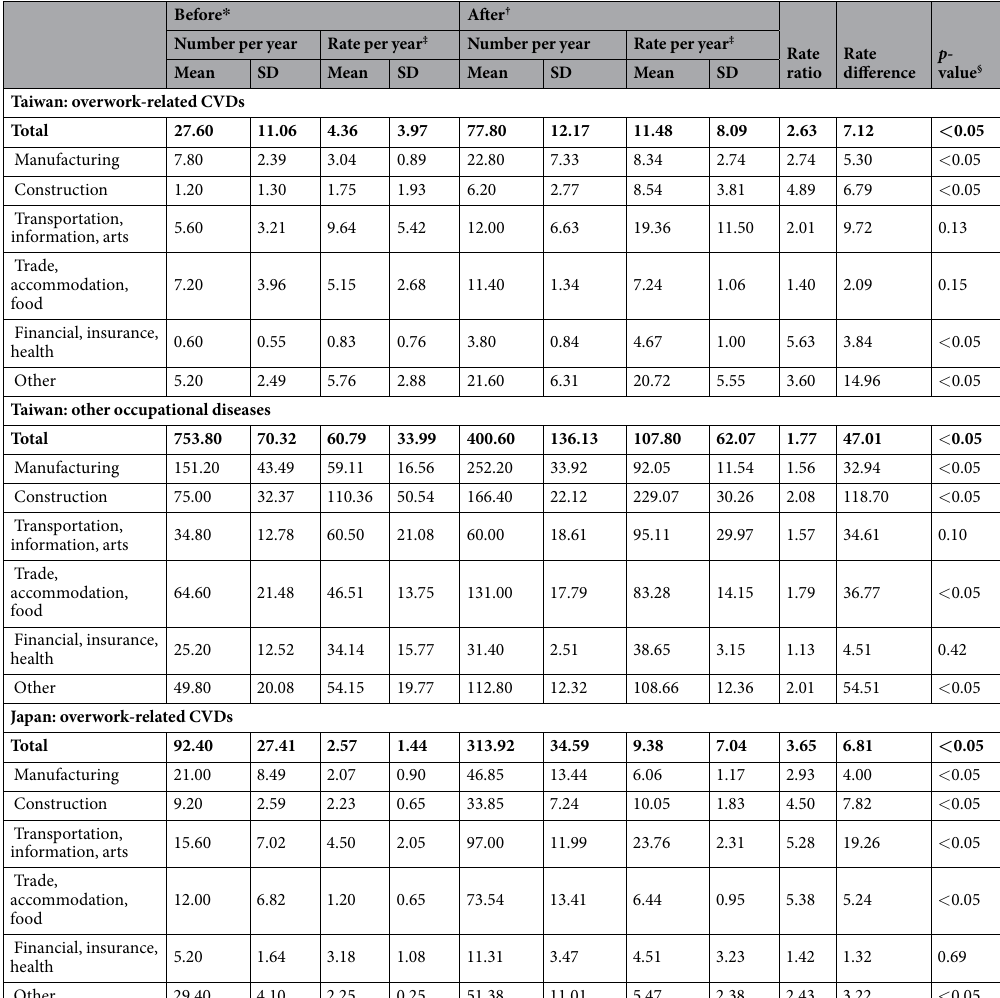
Table 4. Numbers, rates, rate ratios, and rate differences for overwork-related cardiovascular and cerebrovascular diseases (CVDs) and other occupational diseases in Taiwan and Japan before and after implementation of new criteria for overwork-related CVDs. SD = standard deviation. * Defined as 5 years before new criteria: 2006–2010 for Taiwan and 1997–2001 for Japan. † Defined as 5 years after new criteria: 2011–2015 for Taiwan and 2002–2006 for Japan. ‡ Per million employees. § Wilcoxon signed-rank